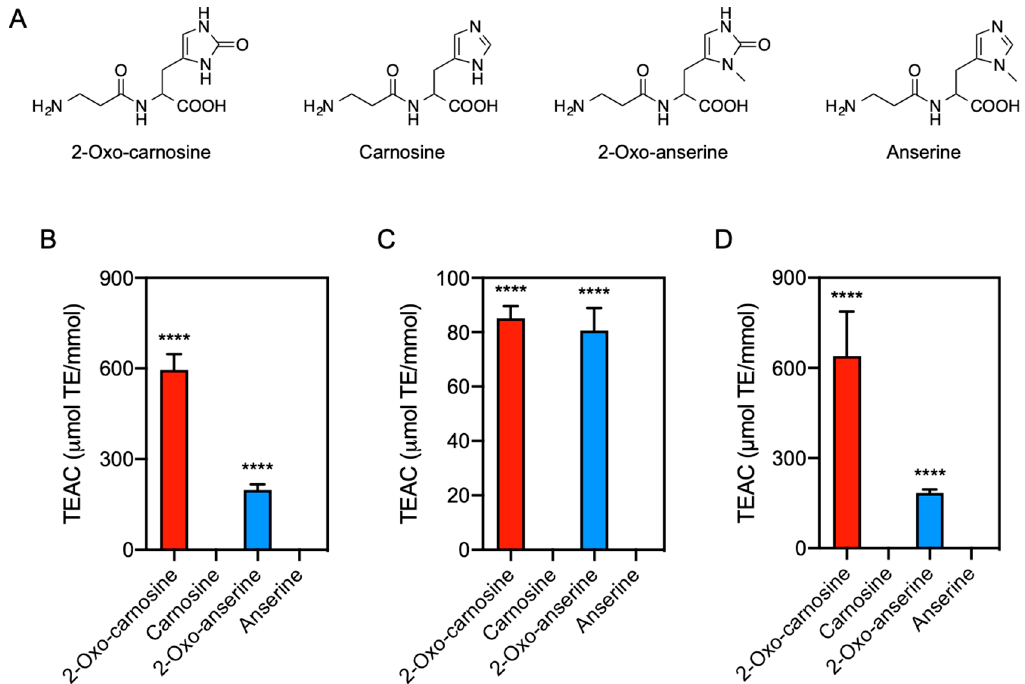
Figure 1. Antioxidant capacity of 2-oxo-IDPs and IDPs. ( A ) Molecular structures of 2-oxo-carnosine, carnosine, 2-oxo- anserine, and anserine. ( B – D ) Antioxidant capacity of 2-oxo-IDPs and IDPs was evaluated by DPPH radical scavenging assay ( B ), ferric reducing/antioxidant power assay ( C ), and oxygen radical absorbance capacity assay ( D ). Data are expressed as Trolox equivalent antioxidant capacity (TEAC): μ mol Trolox equivalent (TE) per mmol samples. Data are presented as means ± standard error of the mean (SEM) ( n > 4). **** p < 0.0001 versus the corresponding IDPs, compared using unpaired Student’s t test.